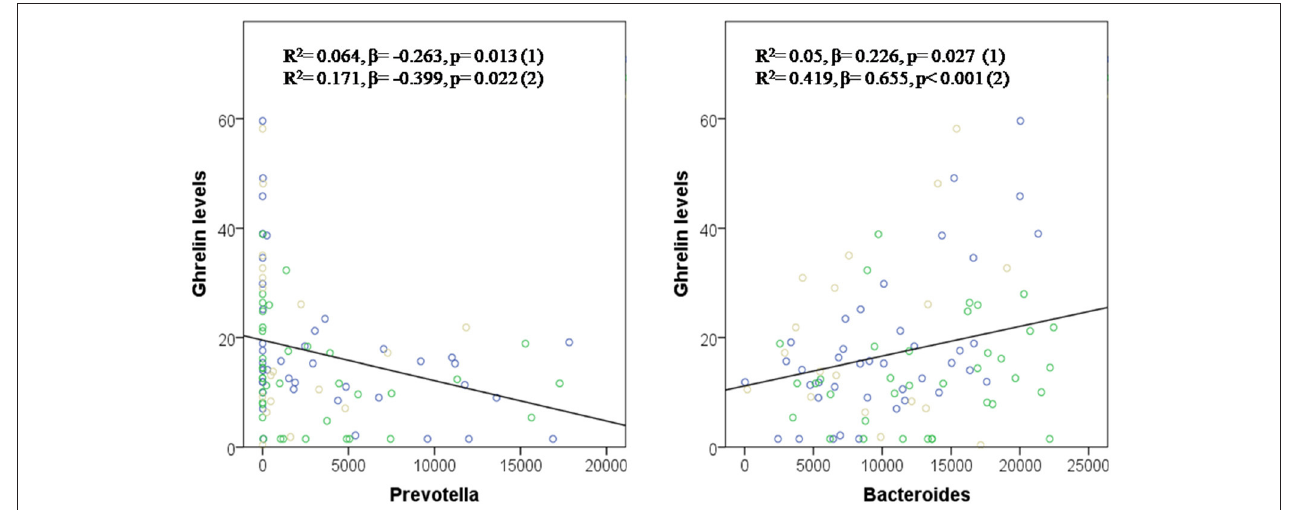
FIGURE 2 | Prevotella and Bacteroides in the prediction of fasting ghrelin levels. Dependent variable: ghrelin levels. Model (1): Linear Univariate regression model. Model (2): Linear multivariate regression model adjusted by age, sex, and BMI. The brown circles belong to the control group; blue circles to patients before treatment; and green circles to patients after